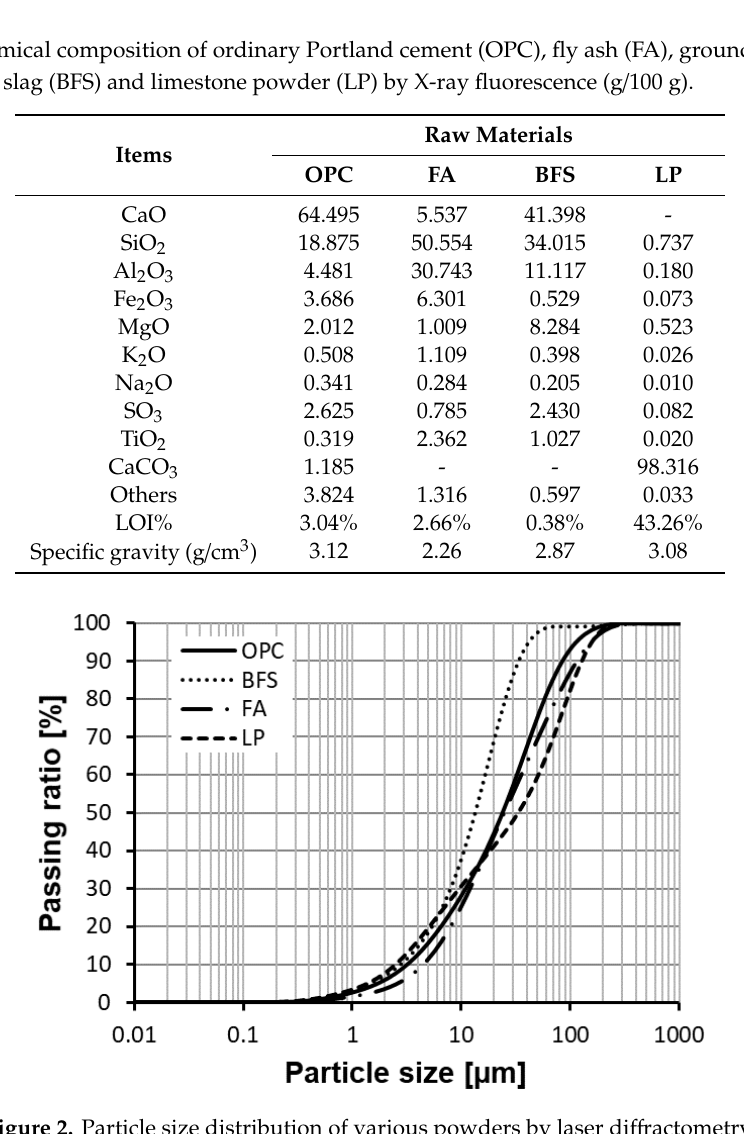
Figure 2. Particle size distribution of various powders by laser diffractometry.